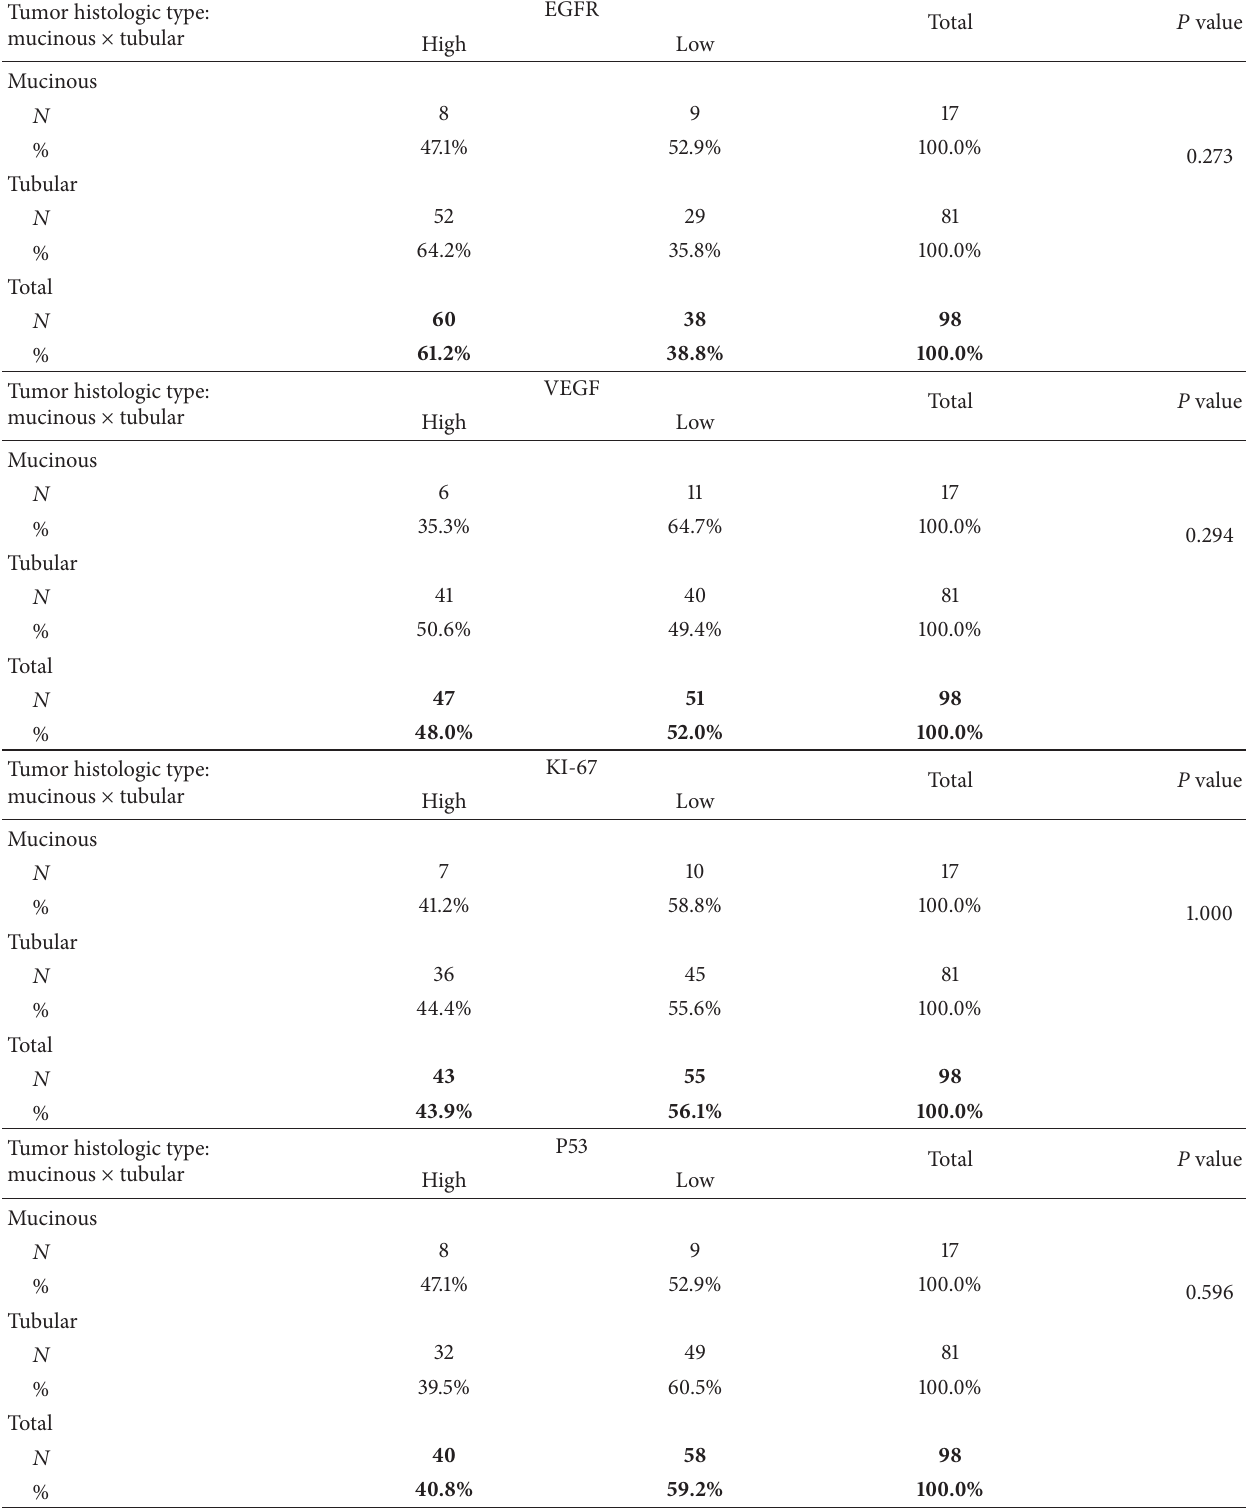
Table 9: The distribution of expression levels per IHC of proteins corresponding to ITGB-5, ITGA-3, MMP-2, MMP-9, and FN-1 ECM genes and EGFR, VEGF, KI-67, P53, and Bcl-2 molecules as per mucinous and tubular tumor types of CRC ( 𝑛 = 114